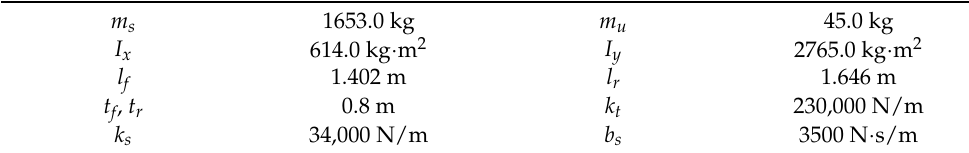
Table 1. Parameters of the 7-DOF full-car model [29].